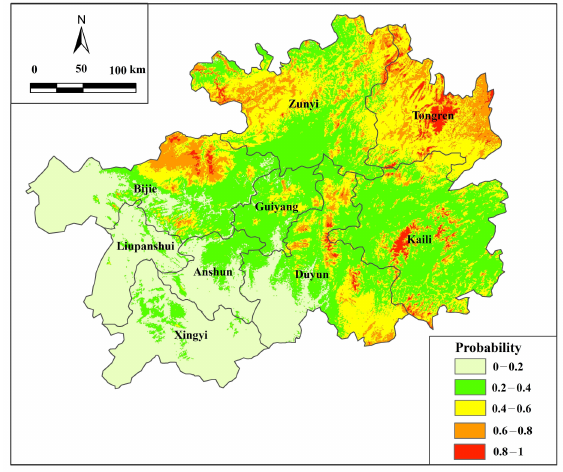
Figure 4. Potential probability under current climate.